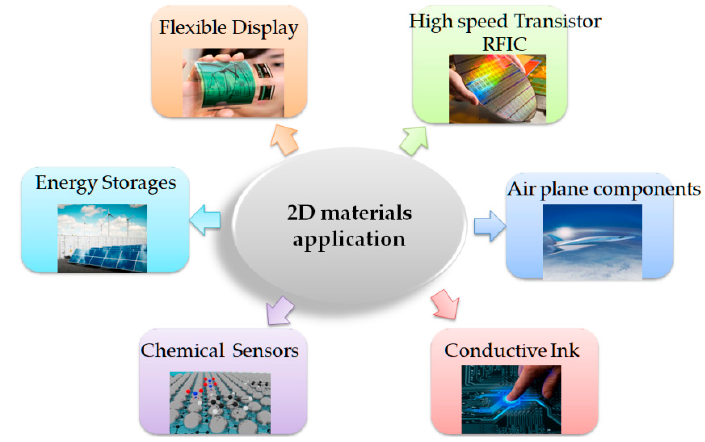
Figure 1. Application based on 2D materials.